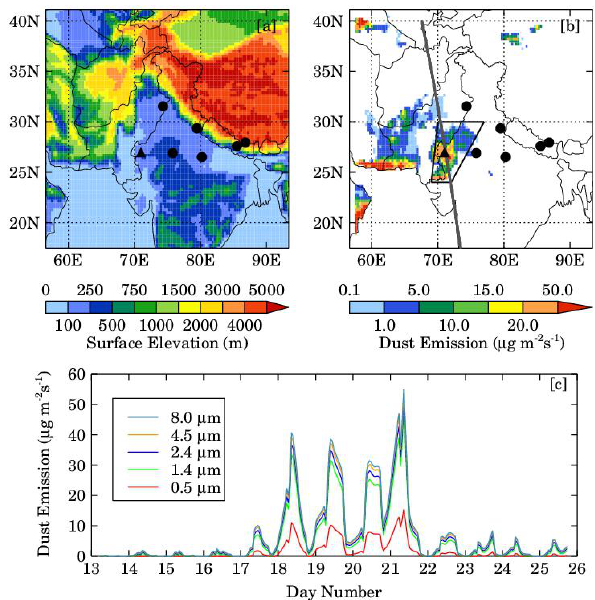
Fig. 1. The WRF-Chem model domain showing (a) topography and (b) spatial distribution of dust emissions averaged over 13–25 April 2010. Black circles show the geographical location of AERONET sites and the black triangle shows the location where the time series of dust emissions from WRF-Chem is shown in (c) for the period of 13–25 April 2010. (b) Also shows the location of Thar Desert (en- closed by solid black lines) and CALIPSO satellite overpass (grey line) over the model domain on 20 April